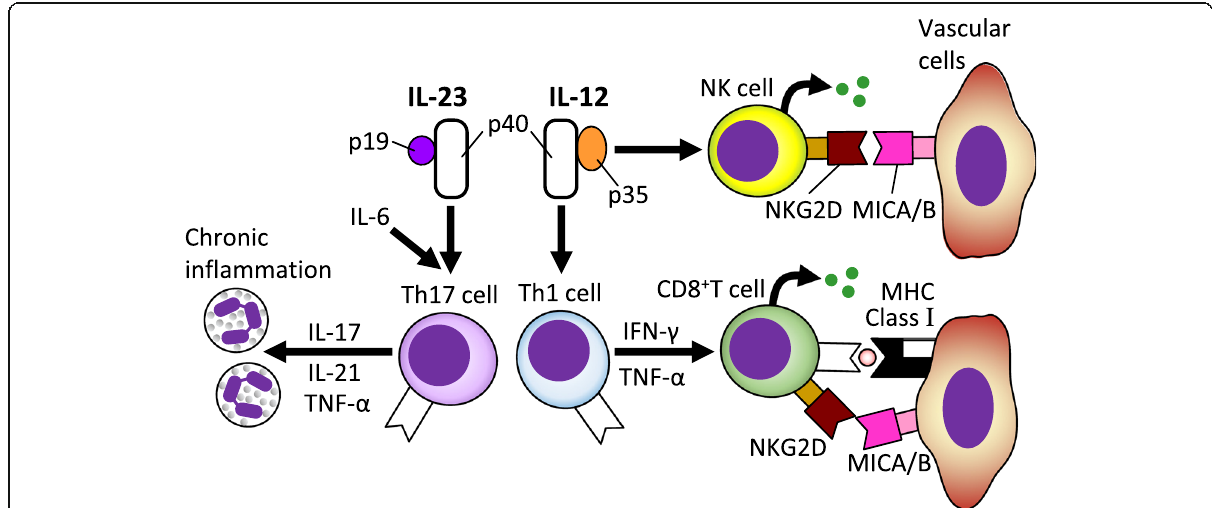
Fig. 2 Cytokines in the pathophysiology of TAK